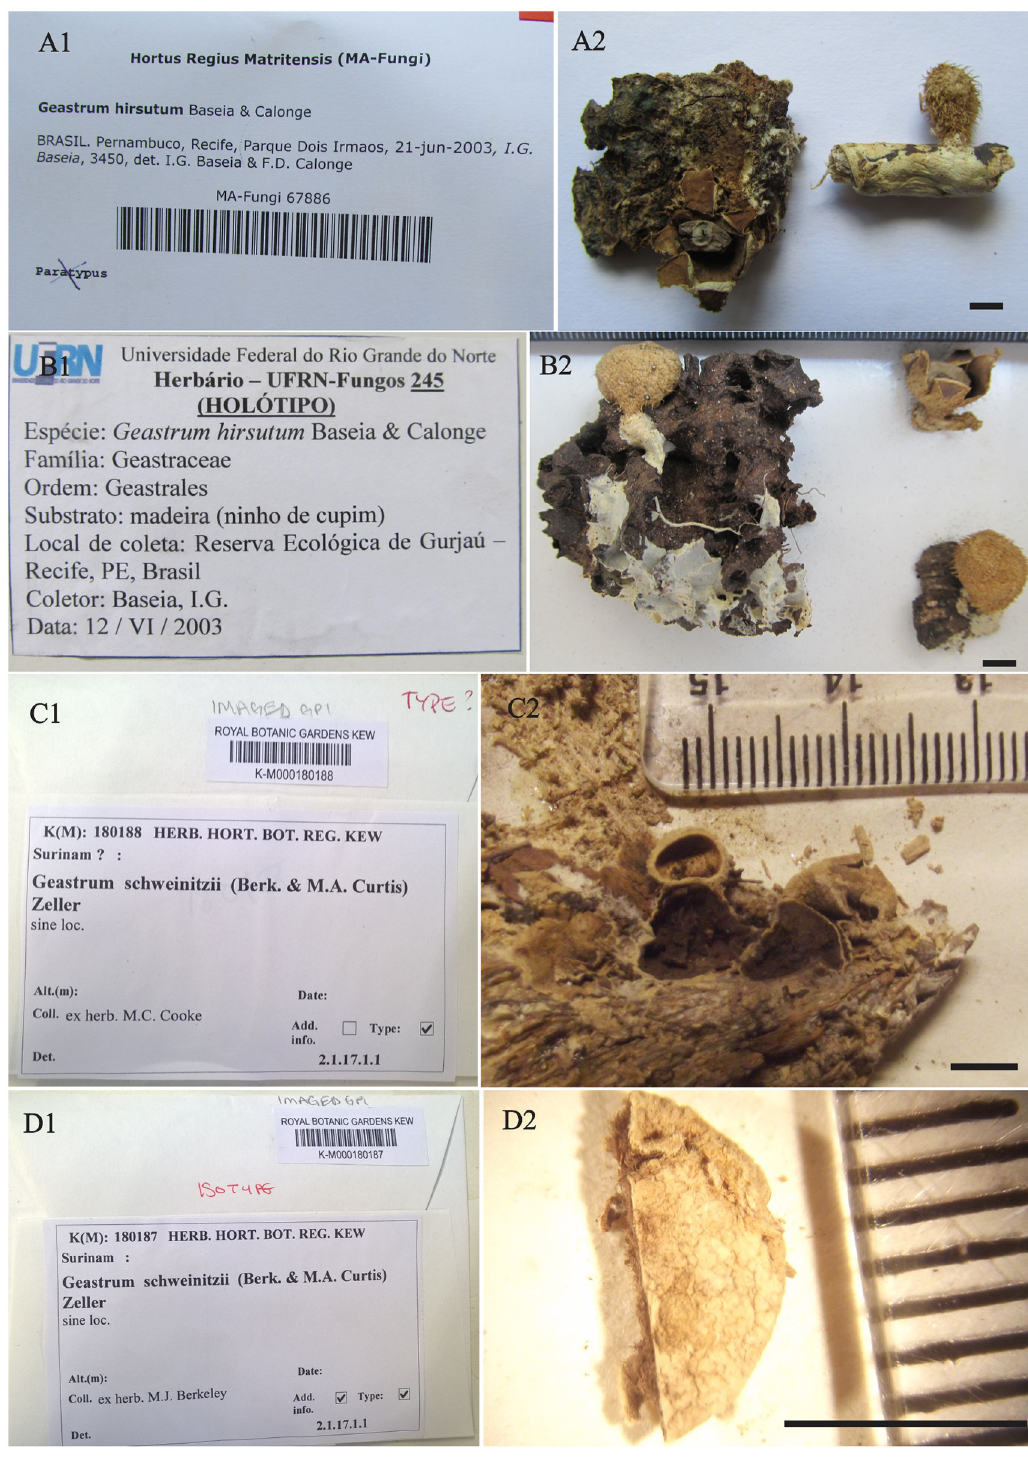
Fig 2. Type collections of Geastrum hirsutum and Geastrum schweinitzii . (A) Geastrum hirsutum MA-Fungi 67886, paratype. (B) Geastrum hirsutum UFRN-Fungos 245, holotype. (C) Geastrum schweinitzii K (M) 180188, type. (D) Geastrum schweinitzii